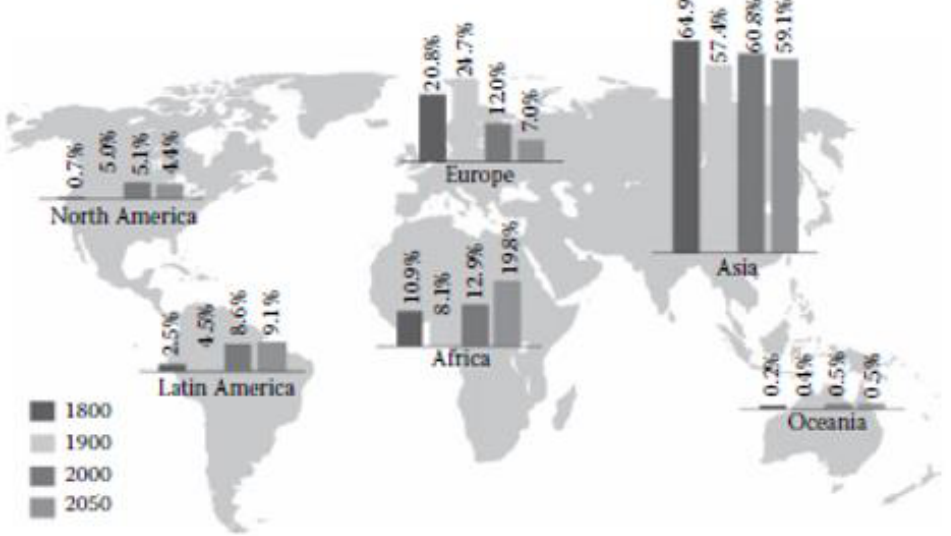
Figure 2. Distribution of world population